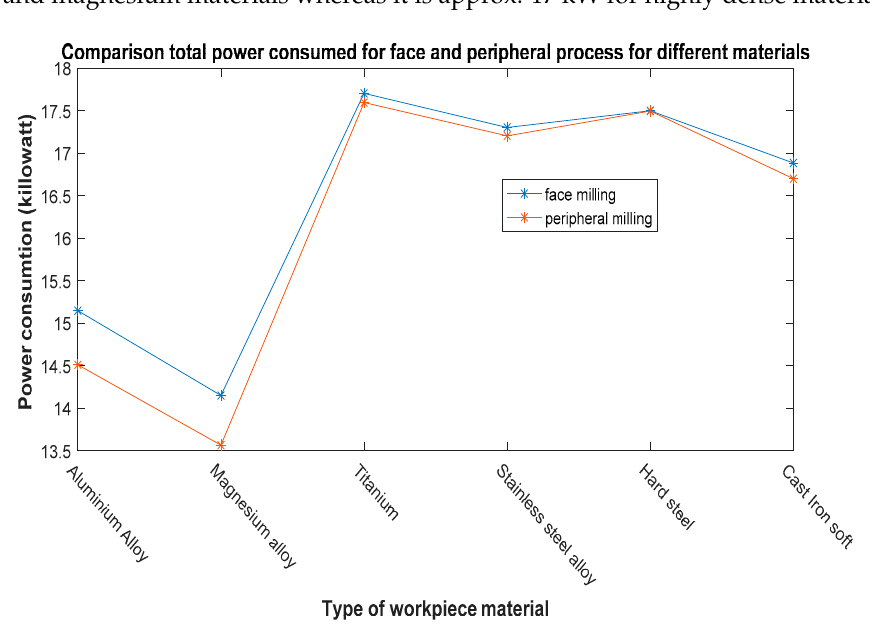
Figure 9. Comparison of total power consumed for face and peripheral processes for different materials.